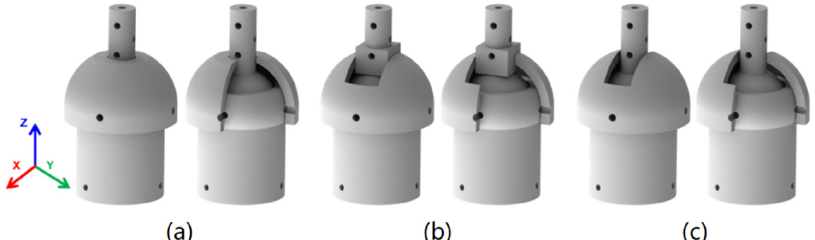
Figure 13. The customized variable stiffness joints based on the VSBJ: ( a ) The variable stiffness twisting joint; ( b ) the variable stiffness revolute joint with one degree of freedom; ( c ) the variable stiffness revolute joint with two degrees of freedom. (The right image in each subfigure shows the sectional view of its corresponding variable stiffness joint).